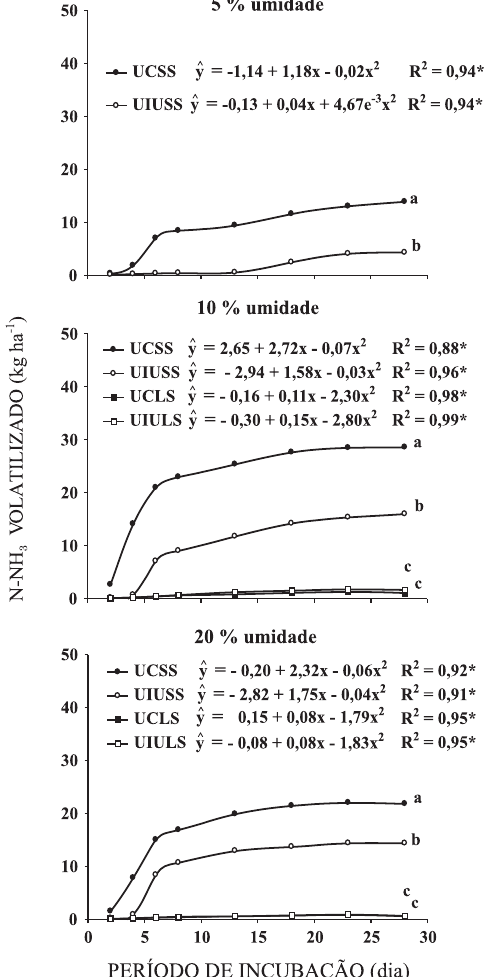
Figura 6. Volatilização acumulada de NH do tempo após a aplicação sobre a superfície do solo de ureia convencional (UC) ou de ureia com inibidor de urease (UIU), no estado sólido (SS) ou líquido (LS), em três teores de água no solo (5, 10 e 20 %). Letras diferentes indicam diferenças entre os tratamentos para a mesma umidade do solo, pelo teste de Tukey (p < 0,05). * Significativo (p <